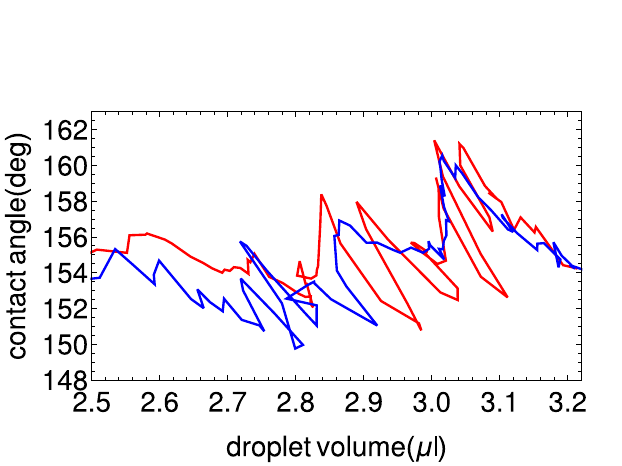
Figure 5. Snapshots form the movie droplet-impact-test.avi enclosed in the supplementary material. The corresponding times are given in the upper left corner of frames.